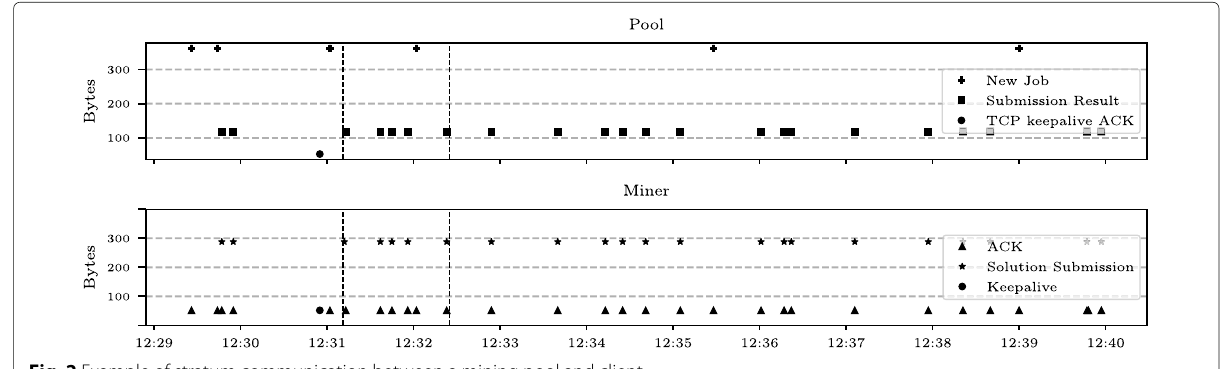
Fig. 2 Example of stratum communication between a mining pool and